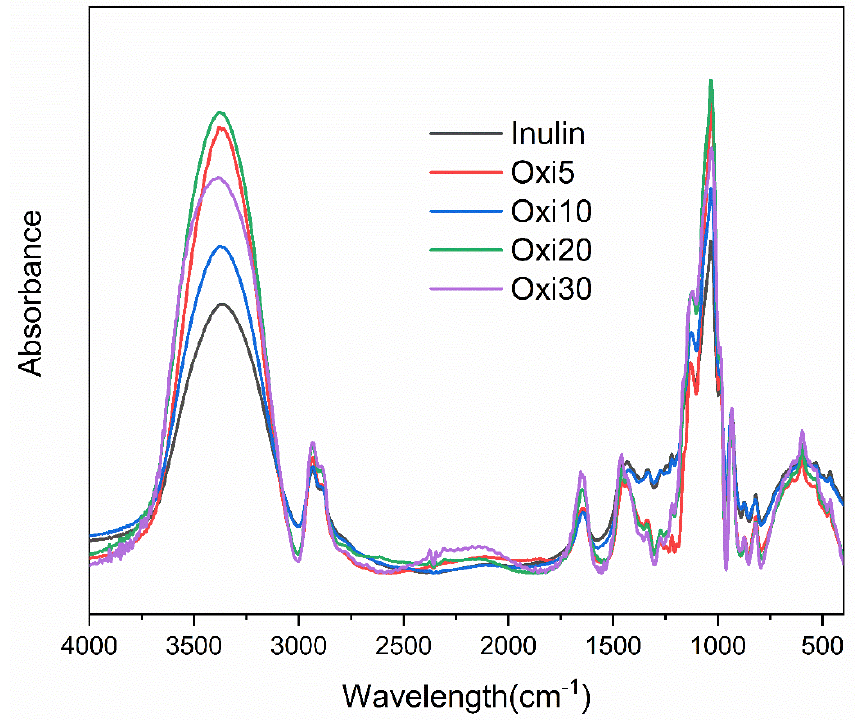
Figure 1. Fourier transform infrared spectroscopy (FTIR) spectra for all the modified inulin samples and raw inulin.